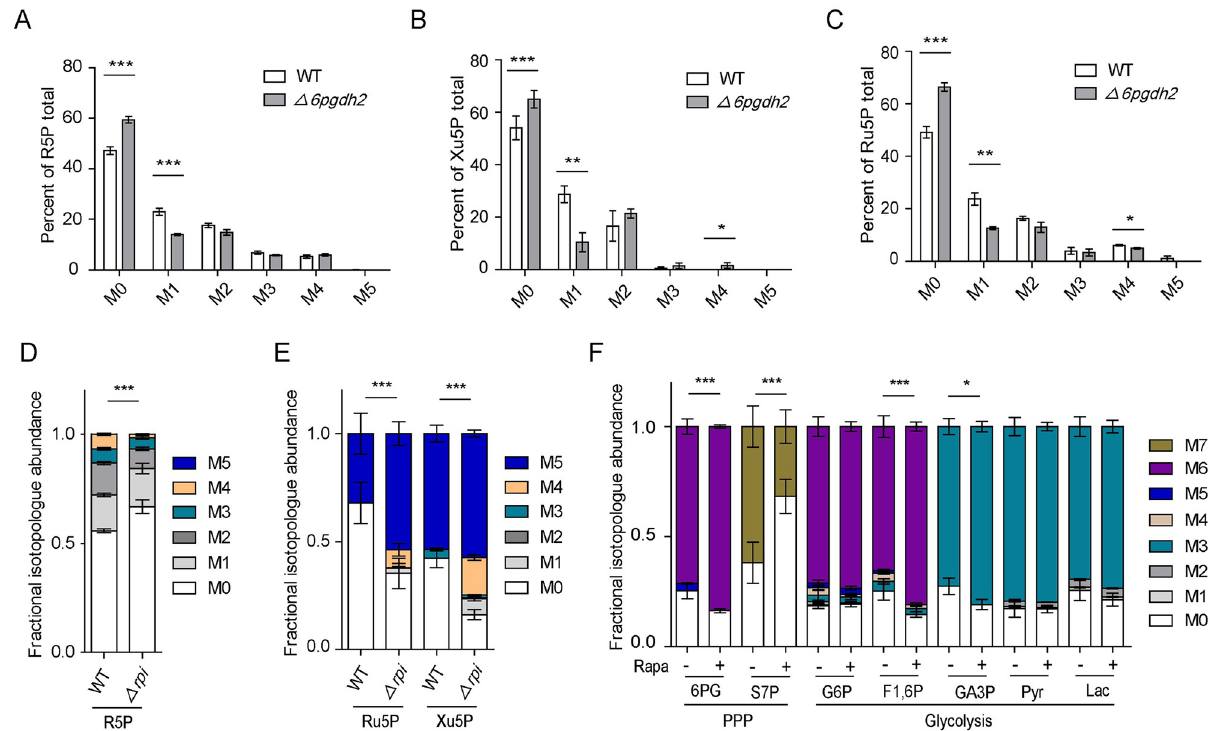
Fig 7. Tg 6PGDH2 and Tg RPI are required to incorporate glucose-derived carbon into the pentose phosphate pathway. (A-C) , Tg 6PGDH2-cKD (WT) and Δ 6pgdh2 mutants were propagated with HFF monolayers cultured in glucose-free DMEM medium supplemented with 8 mM 1,2- 13 C 2 - glucose for 12 h. Subsequently, intracellular parasites were collected, metabolites were extracted from the parasites, and the relative abundance of isotopologues was determined by LC-MS. M0 means parental unlabeled. M1-M5 represents the number of carbons in a selected metabolite labeled with 13 C atom. Values are means ± SEM from four independent experiments (n = 4). Student’s t-test, � , P < 0 . 05 ; �� , P < 0 . 01 ; ��� , P < 0 . 001 . (D) , Tg RPI-cKD (WT), and Δ rpi mutants were cultured the same way as above. Metabolite from the intracellular parasites was determined by LC-MS. Values are means ± SEM from five independent experiments (n = 5). ��� , P < 0 . 001 by two-way ANOVA. ( E ), Extracellular Tg RPI-cKD (WT) and Δ rpi parasites were incubated in a glucose-free medium containing 8 mM [U- 13 C] glucose for 4 h. Incorporation of 13 C into Ru5P and Xu5P was determined by UHPLC-HRMS platform. M0-M5 represents the number of carbons in a selected metabolite labeled with 13 C atom. Values are means ± SEM from five independent experiments (n = 5). ��� , P < 0 . 001 by two-way ANOVA. (F) , Freshly egressed tachyzoites (3 × 10 7 ) of Tg RPI-cKD left untreated or pretreated with rapamycin for 4 days were collected, syringe released, and then incubated in medium containing 8 mM [U- 13 C] glucose for 4 h. Incorporation of 13 C into glycolysis and PPP intermediates was determined by UHPLC-HRMS platform. M0-M7 represents the number of carbons in a selected metabolite labeled with 13 C atom. Values are means ± SEM from five independent experiments (n = 5). � , P < 0 . 05 ; �� , P < 0 . 01 ; ��� , P < . 001 ; all by two-way ANOVA.